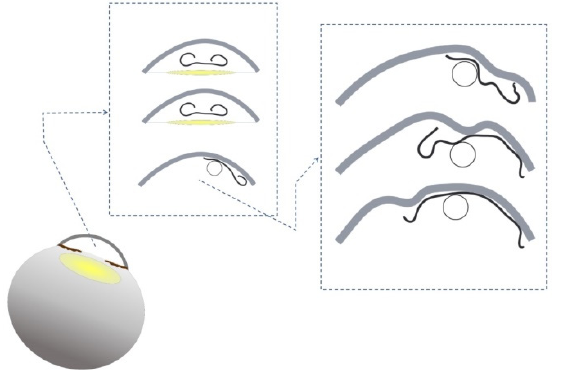
Figure 1. The Descemet membrane endothelial keratoplasty (DMEK) “Wave Maneuver”.